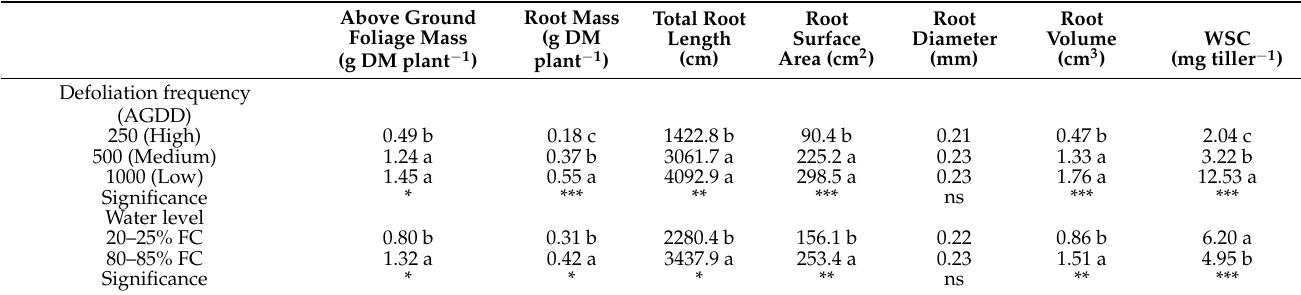
Table 2. Above- and below-ground components of Bromus valdivianus Phil. subjected to three defoliation frequencies (250 [high], 500 [medium] and 1000 [low] accumulated growing degree days) and two soil-water level conditions: 80–85% field capacity (FC) and 20–25% FC, at final harvest